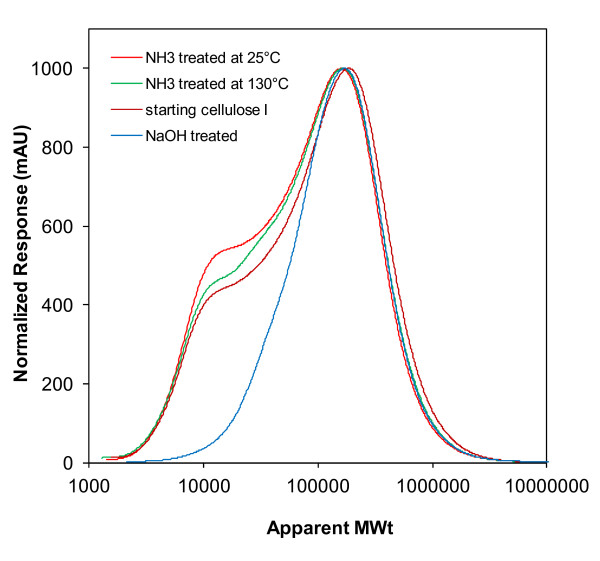
Molecular weight distributions of Avicel PH 101 and treated Avicel samples.